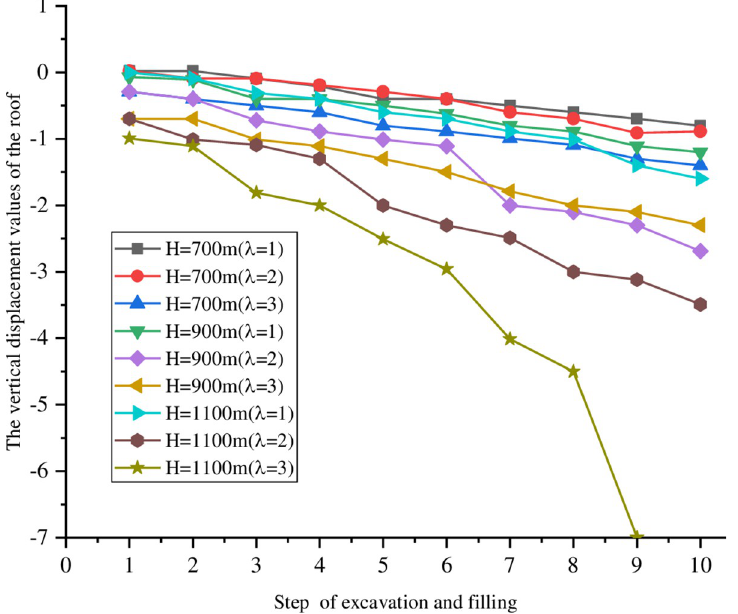
Fig 7. Vertical displacement of the monitoring point on the roof at different depths.